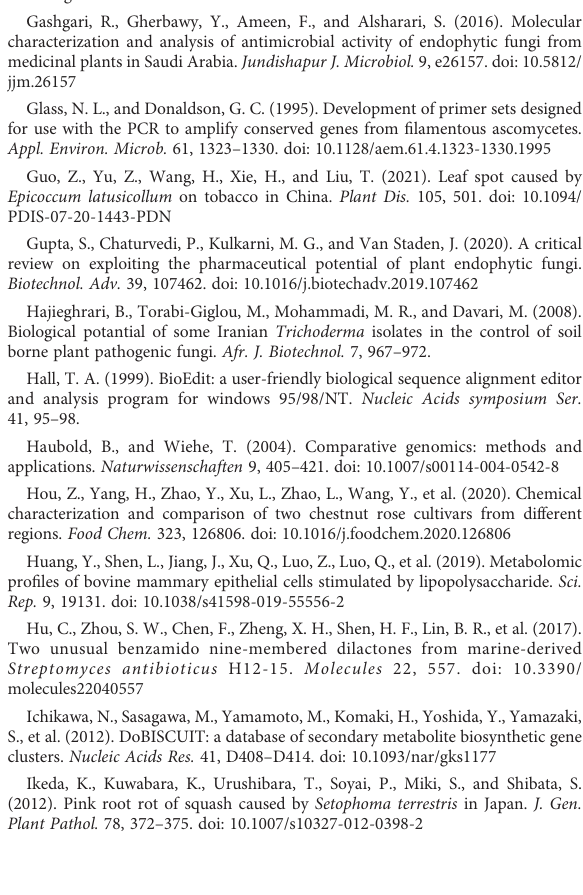
SUPPLEMENTARY FIGURE 1 Phylogenetic analysis of Epicoccum latusicollum HGUP191049, phylogenetic tree generated from a maximum likelihood analysis based